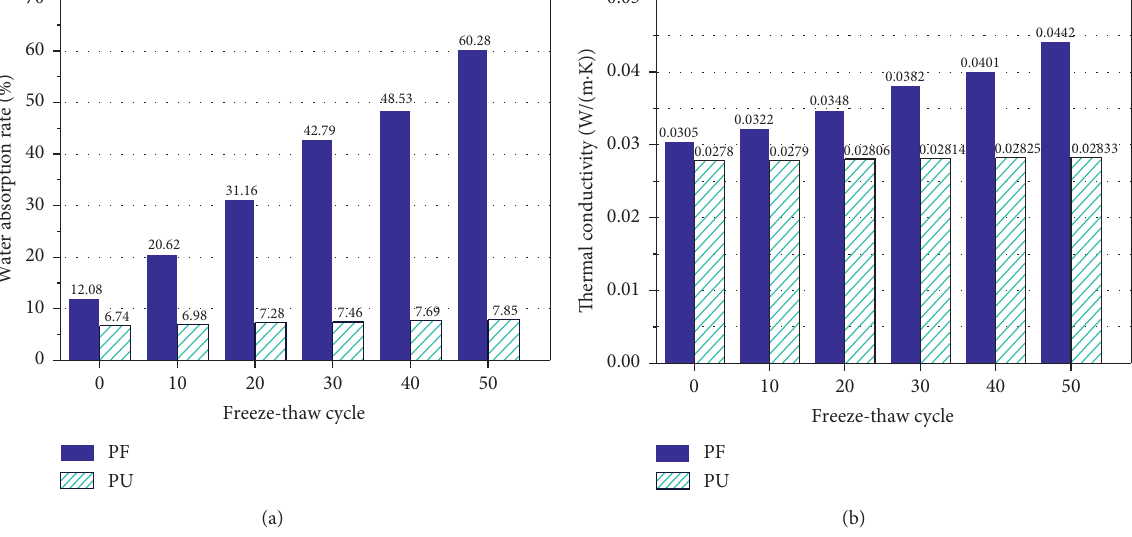
Figure 8: Changes in water absorption and thermal conductivity of insulation materials under freeze-thaw cycles. (a) Water absorption rate. (b) Thermal